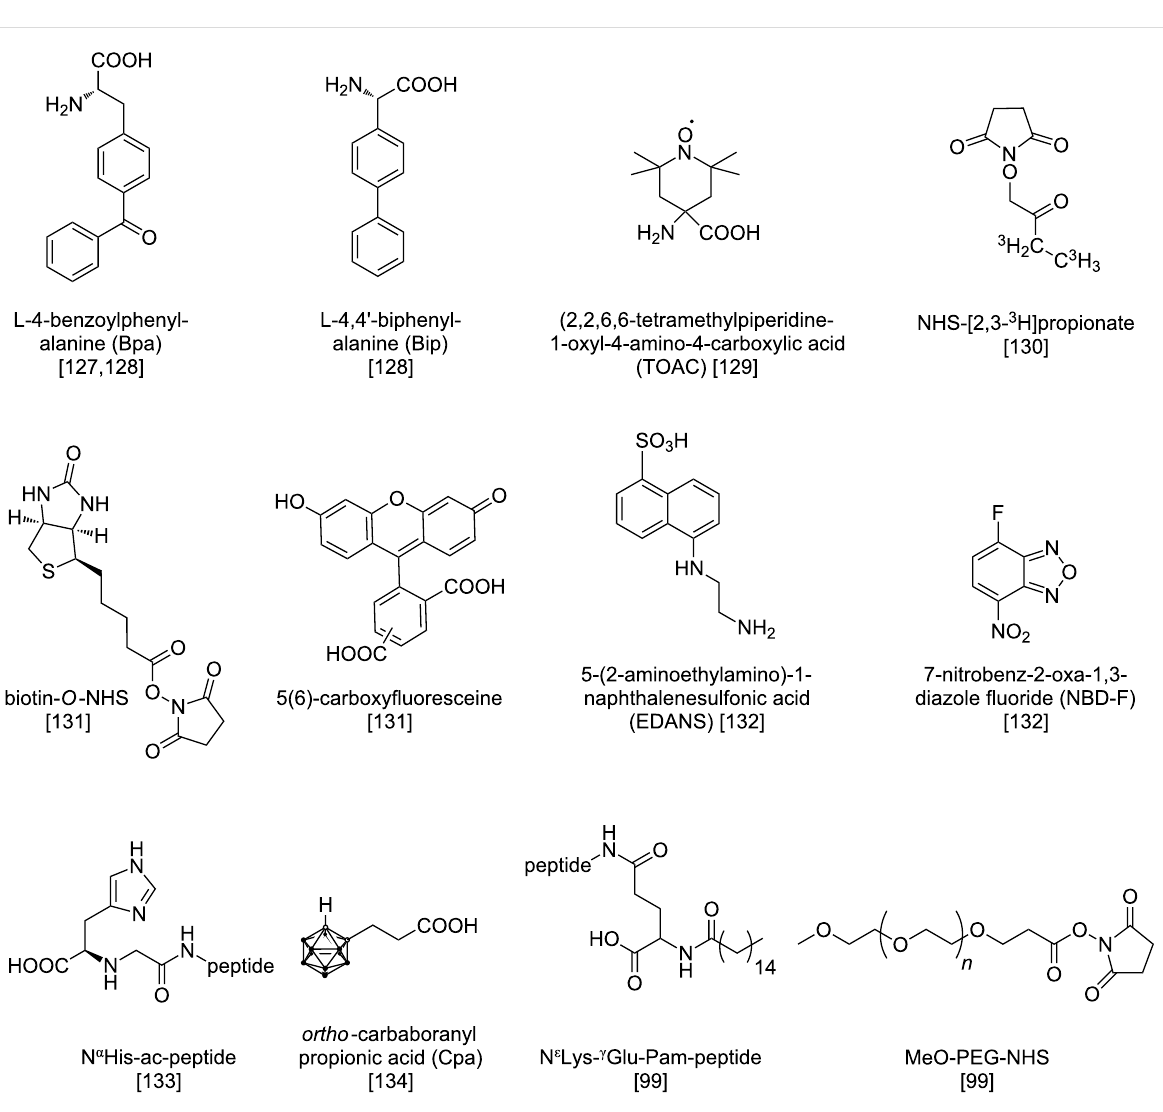
should not be radio-labeled, were protected with